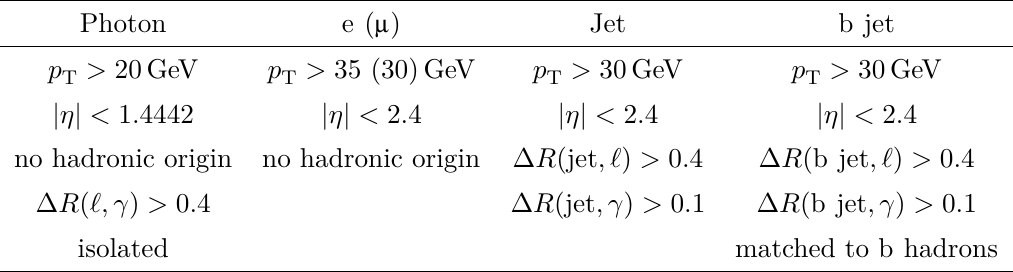
> 5 GeV within a cone T